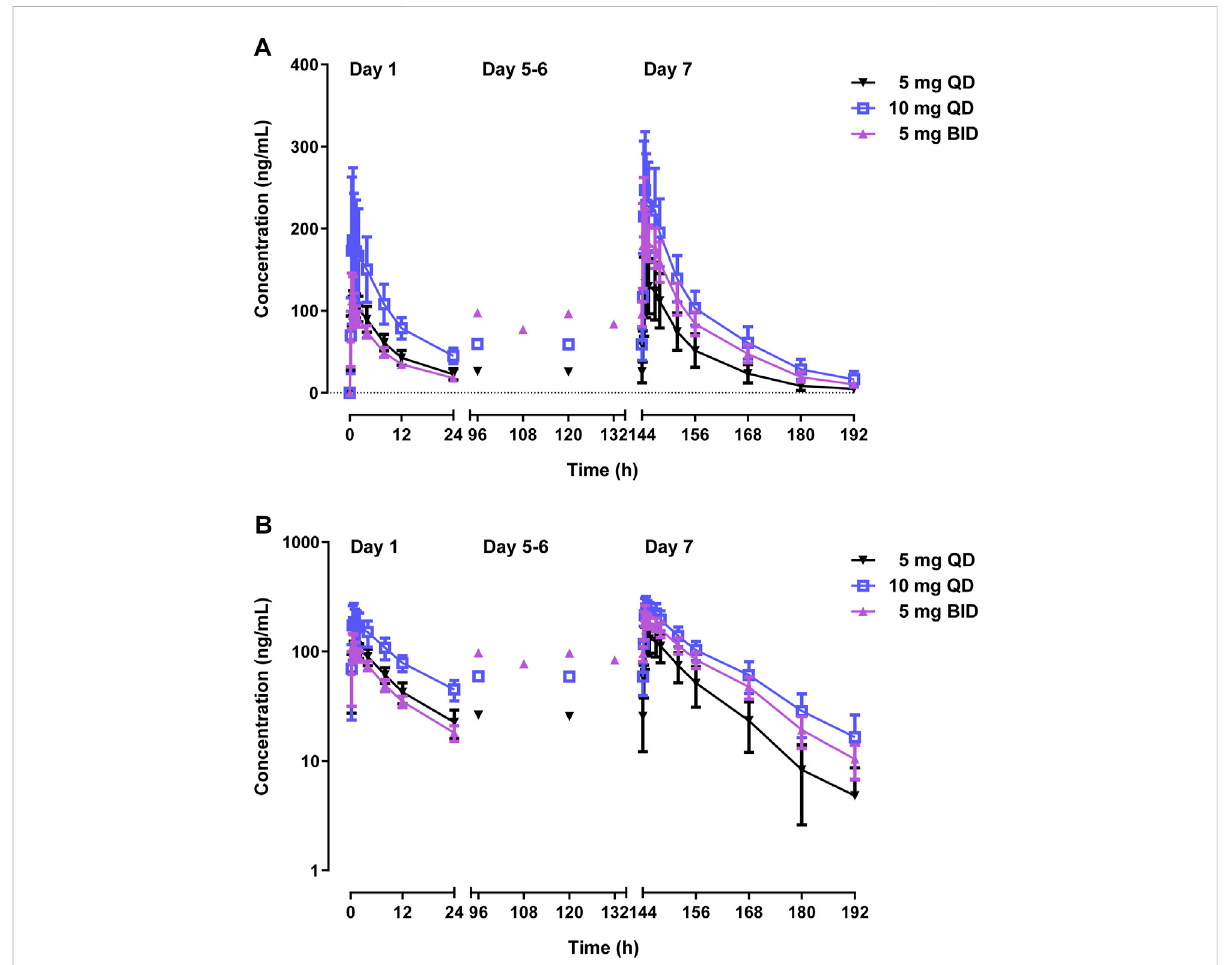
FIGURE 4 Mean plasma concentrations versus time pro fi les following multiple doses of WXFL10203614 (5 mg QD, 10 mg QD and 5 mg BID) in healthy Chinese subjects on linear (A) and semilogarithmic scales (B)